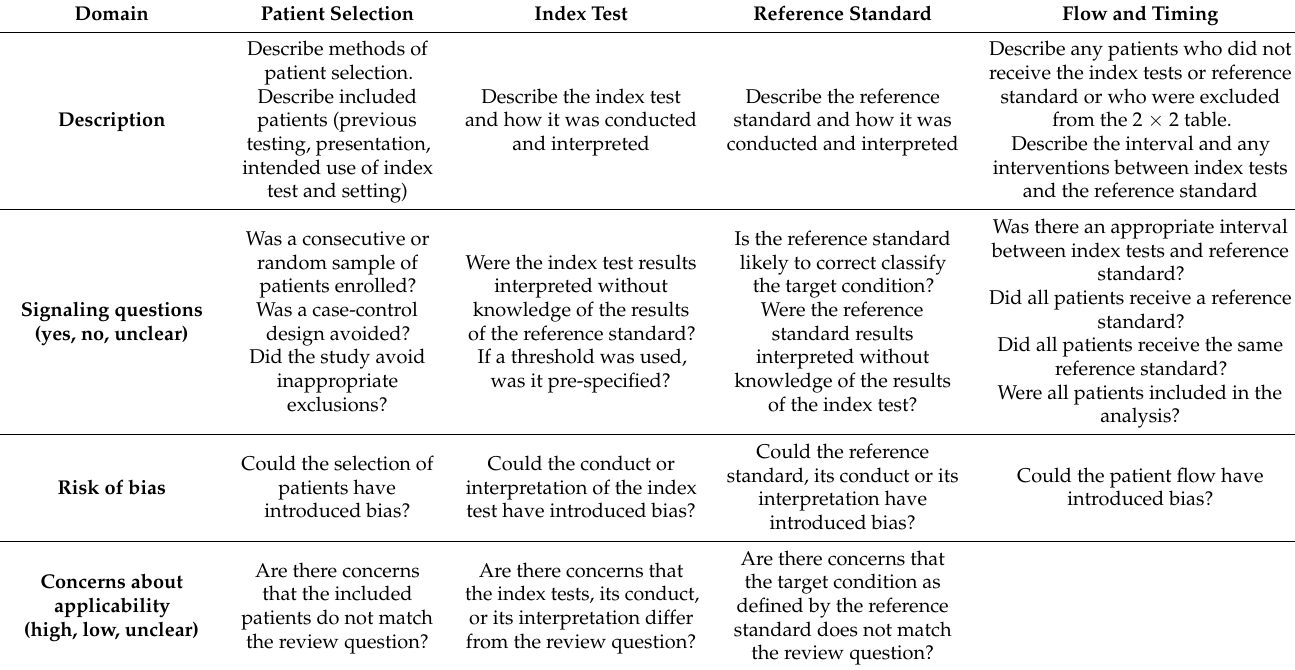
Table 1. Flow-chart for risk of bias and applicability concerns in Quality Assessment of Diagnostic Accuracy Studies